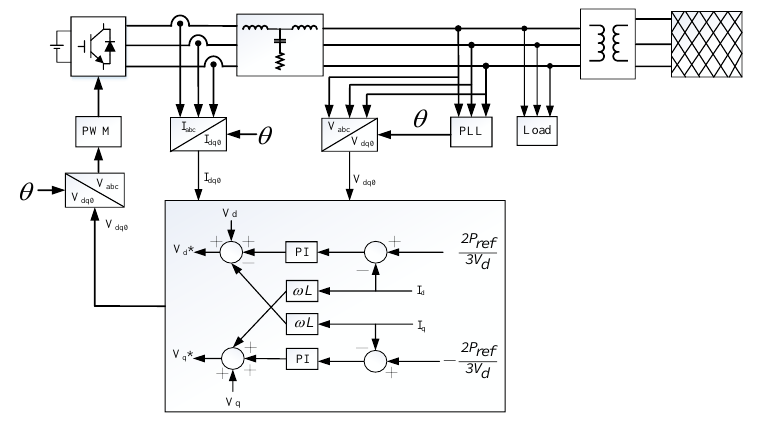
Figure 6. Voltage-source converter controller architecture.